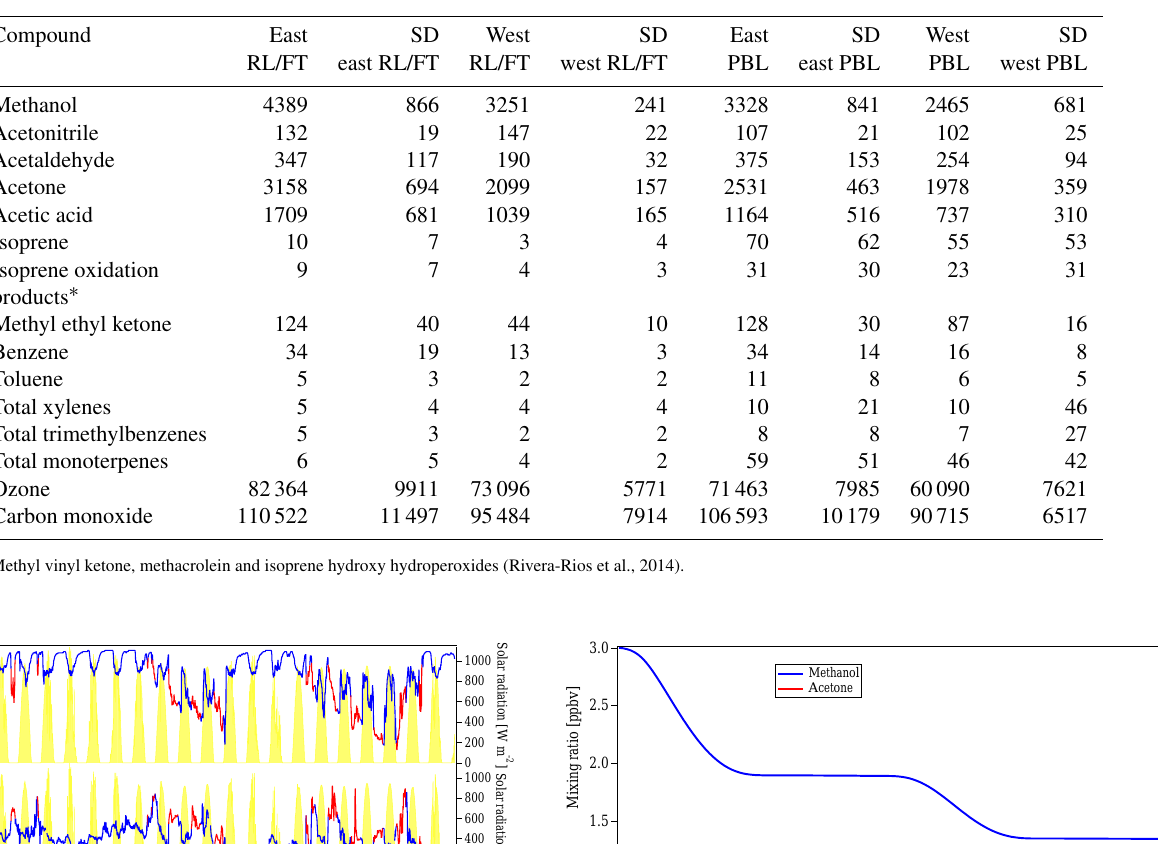
Table 1. Averaged data of VOCs, O 3 and CO and their standard deviation (SD) in pptv based on a 10min time resolution. The data were separated into periods reached by air from eastern or western regions as well as into values measured when the site was within the residual layer/free troposphere (RL/FT) and those recorded when the site was within the PBL.